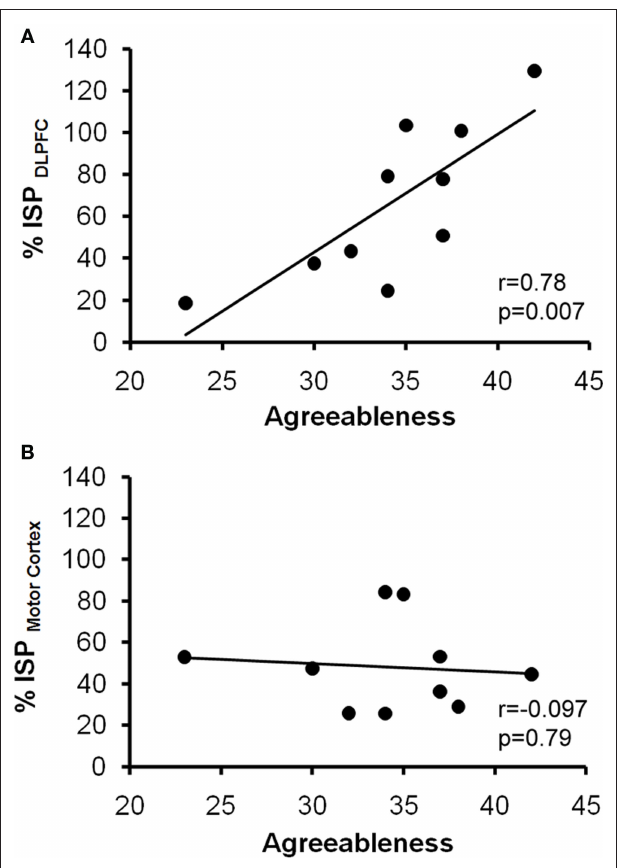
FIguRE 1 | The Relationship between interhemispheric signal propagation and Agreeableness. Data obtained from ten healthy subjects. The x-axes represent the score on Agreeableness, a domain of the NEO-FFI. The y-axes illustrate the TMS-induced interhemispheric signal propagation (ISP) from the left DLPFC to the right DLPFC (A) , and from the left motor cortex to the right motor cortex (B) obtained through equation